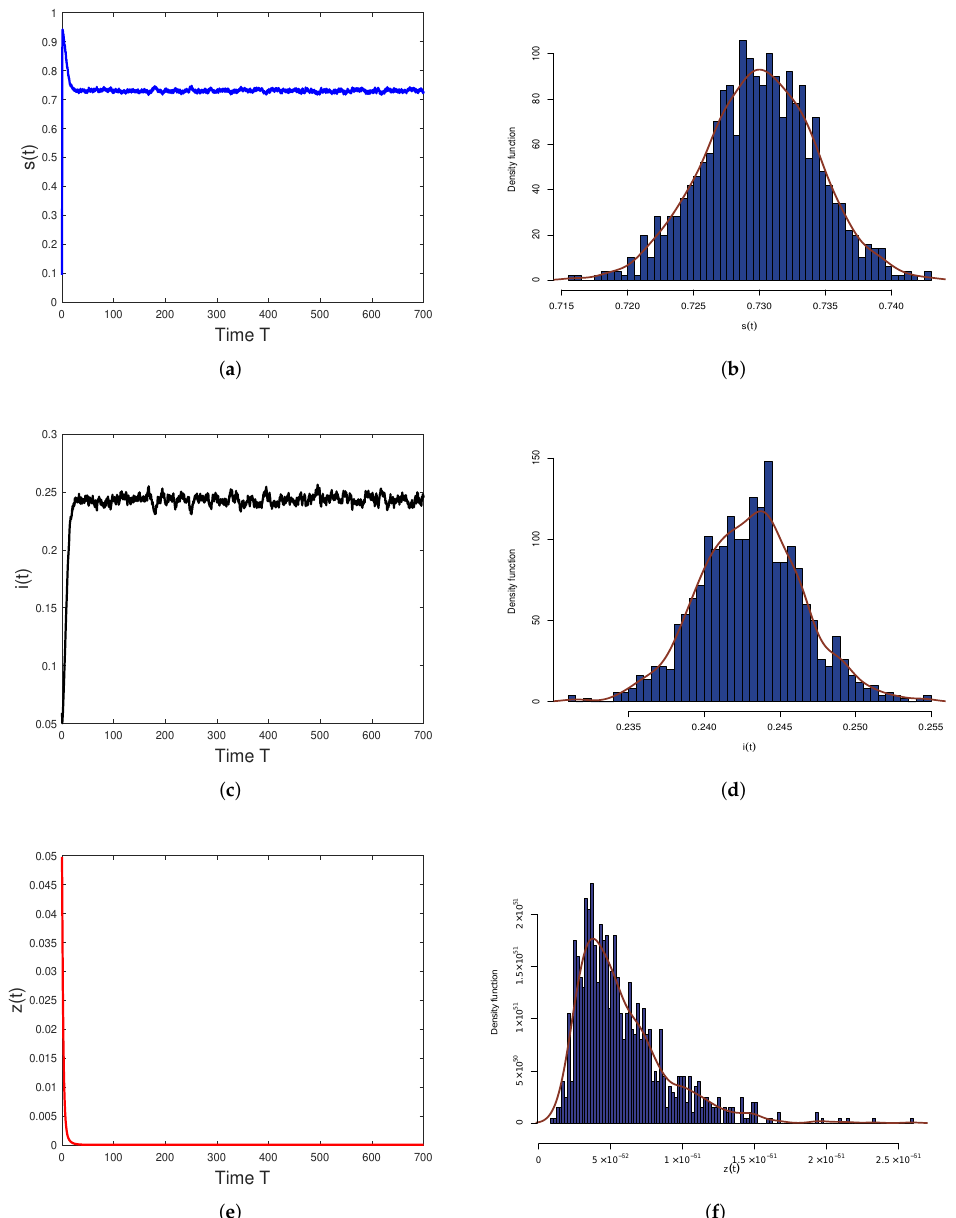
Figure 4. Susceptible phytoplankton s ( t ) and infected phytoplankton i ( t ) are persistent in the mean with probability one, as is zooplankton z ( t ) when we select the parameter values in Table 1 except for b 2 = 0.73 and σ i = 0.01 ( i = 1,2,3 ) . The initial value is ( 0.08,0.06,0.05 ) . ( a – f ) denote the evolution of a single path and the probability density curve (based on the 1000 simulations) of s ( t ) , i ( t ) , and z ( t ) ,